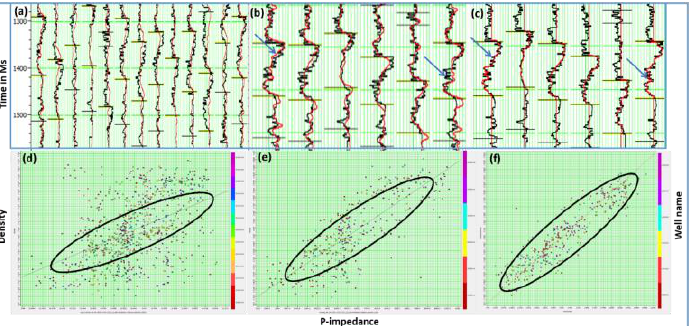
Figure 7. Predicted density from well logs and seismic inverted volumes overlying well logs with original density. ( a ) 13 well log traces, ( b ) 6 well log traces, ( c ) DFNN six well log traces, ( d ) 13 wells, that match between predicted and actual density, ( e ) 6 wells that match between predicted and ac- tual density, and ( f ) 6 well logs that match between predicted and actual density using machine learning with DFNN. The blue rectangle encloses the interval of reservoir logging. The target logs are colored black, while the predicted logs are red. The blue arrow indicates the similarity of the actual and predicted densities of six well logs with and without machine learning with DFNN, and the black oval highlights the fit. We applied the DFNN operator to the seismic inversion dataset for both the baseline and monitor surveys and compared it to other paths, either 13 wells or 6 wells. DFNN provided a higher resolution result than the nonlinear transformation regression curve approach using the 6-well and 13-well tests and appeared to match the well better, espe- cially in the reservoir interval of the target logs (Figure 8).